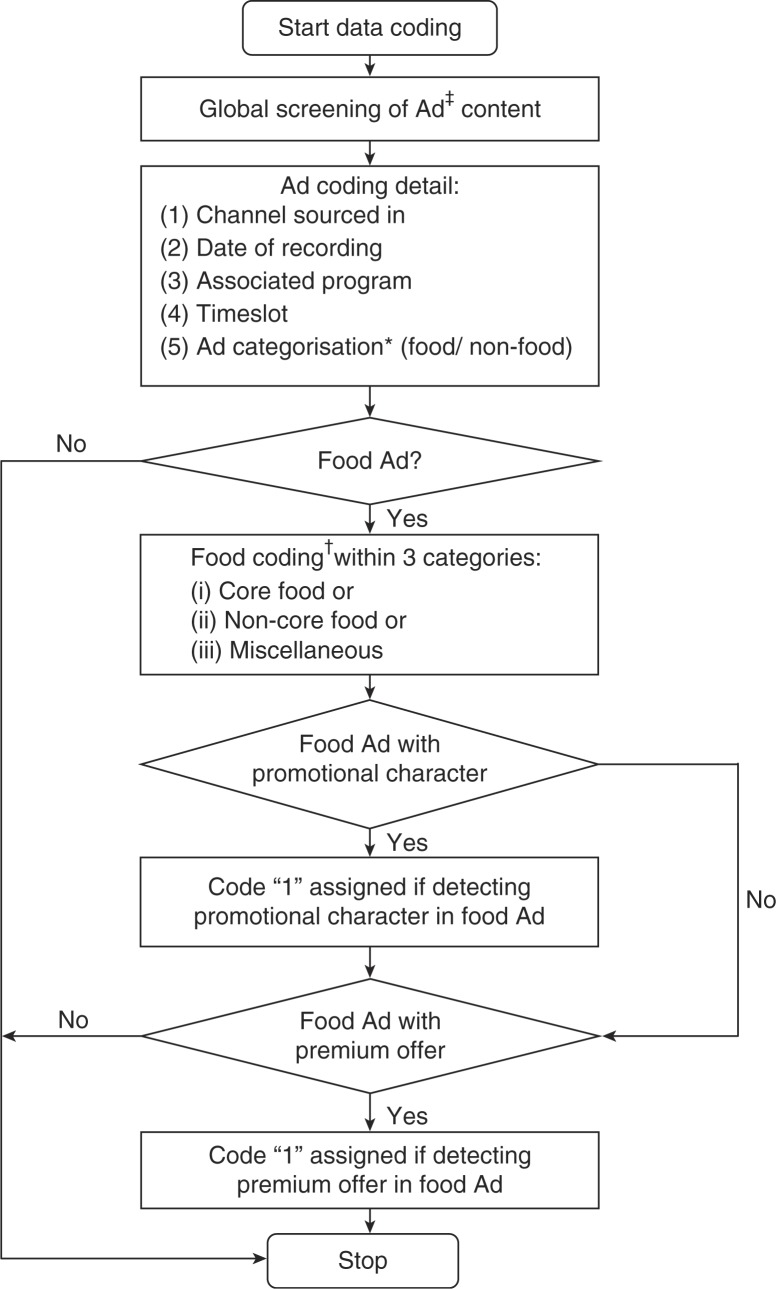
Process algorithm of data coding. Ad: advertisement. *Code of product, e.g. retail food and drink, channel promotion, education etc. †Protocol with 36 food codes developed based on previous international methodology for TV food advertising (26).